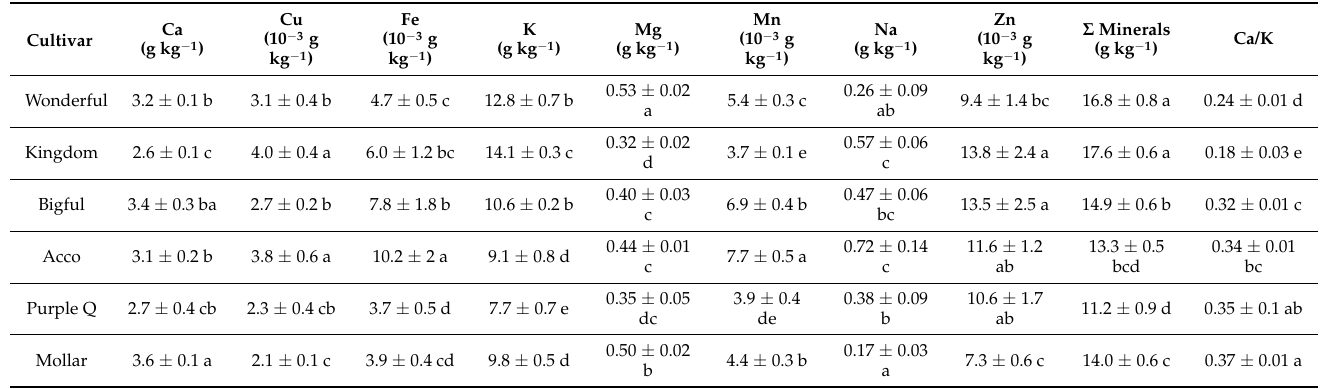
Table 5. Mineral contents in pomegranate peel after storage at 2 ◦ C plus 20 d at 20 ◦